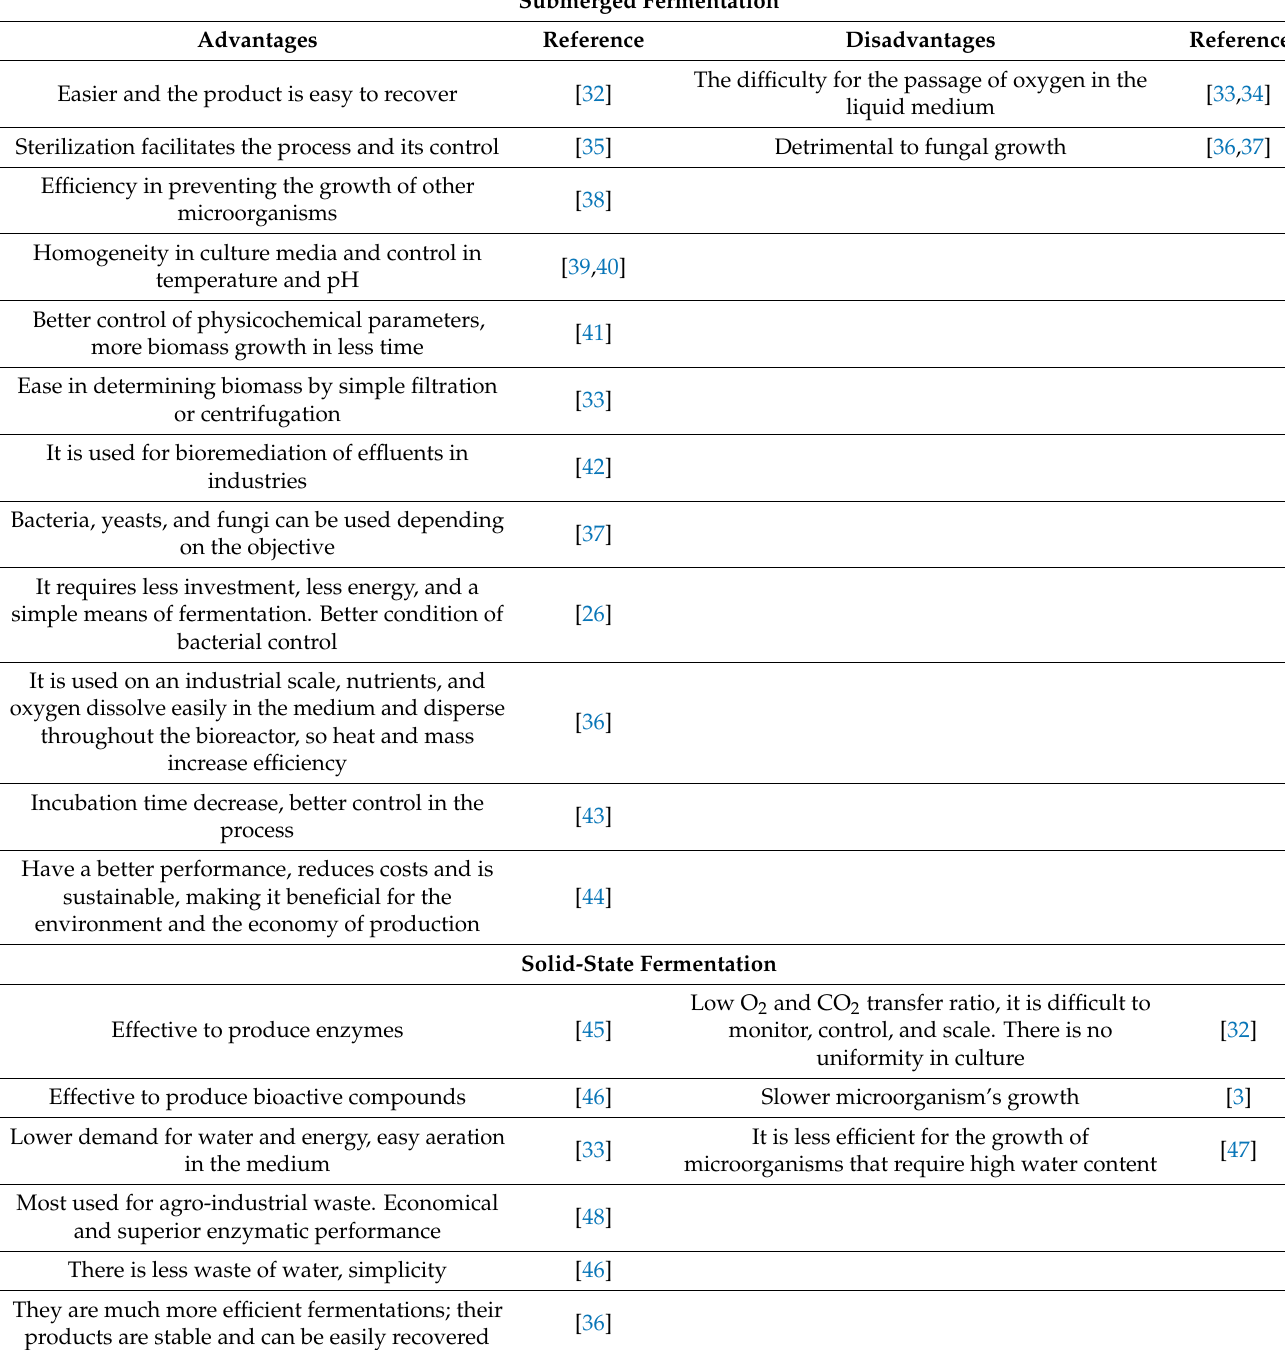
Table 1. Advantages and disadvantages of submerged and solid-state